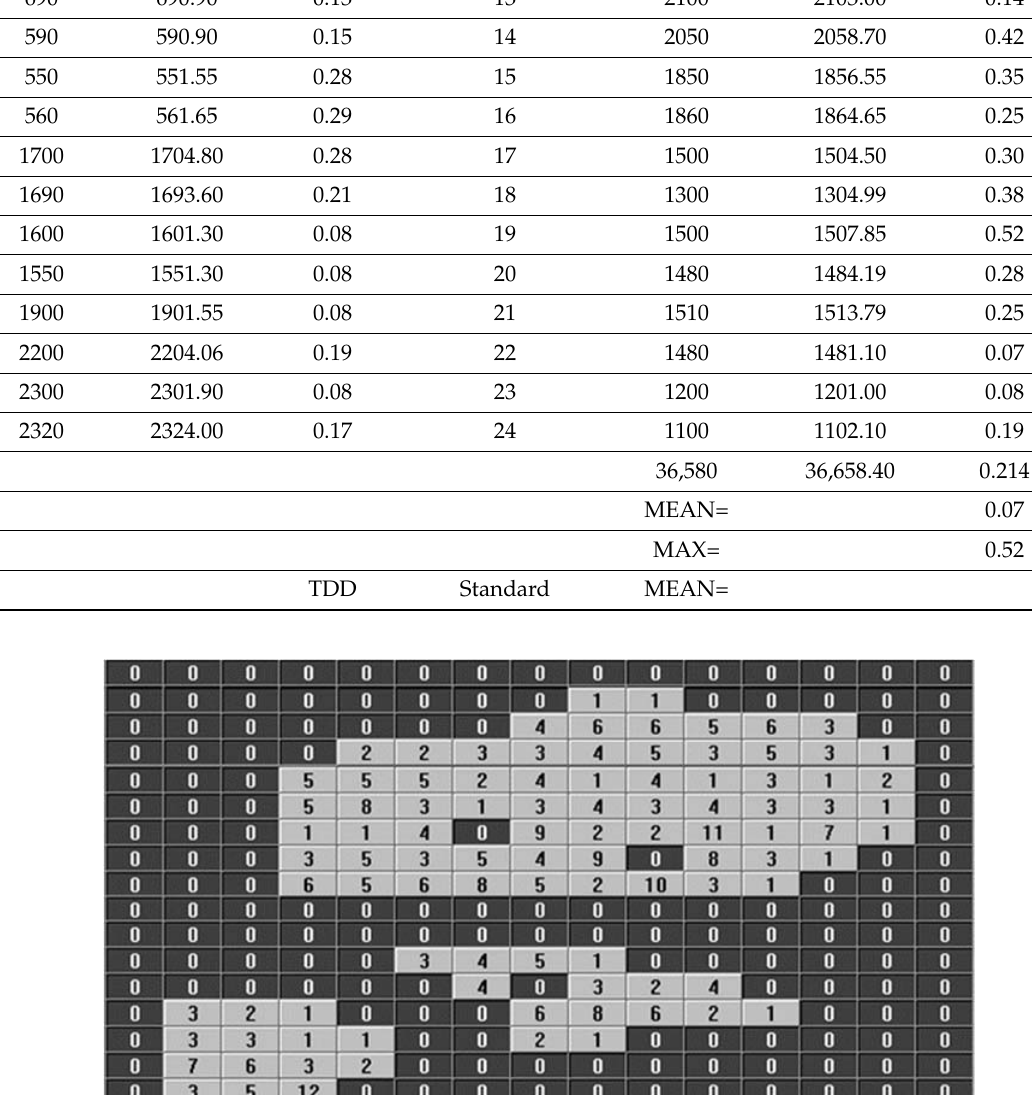
Figure 16. Proposed course of daily energy consumption for Thursday and its comparison with the standard.